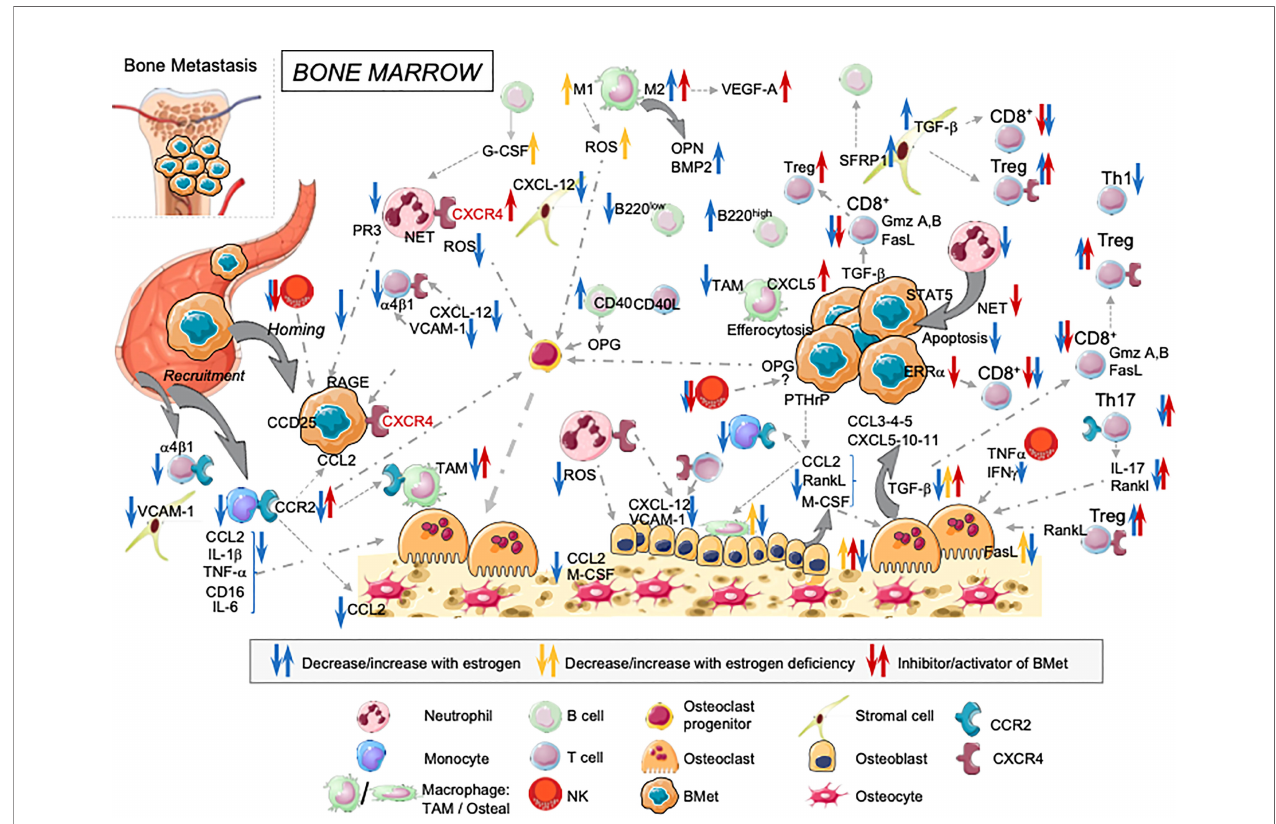
FIGURE 1 | Overview of estrogens regulating immune landscape on the bone marrow cells: consequences on cancer cells anchorage and tumor progression in bone. Estrogens in fl uence BM cells at different steps. They modulate both their development and functions with direct consequences on bone osteogenesis, cancer cell implantation and tumor growth in the